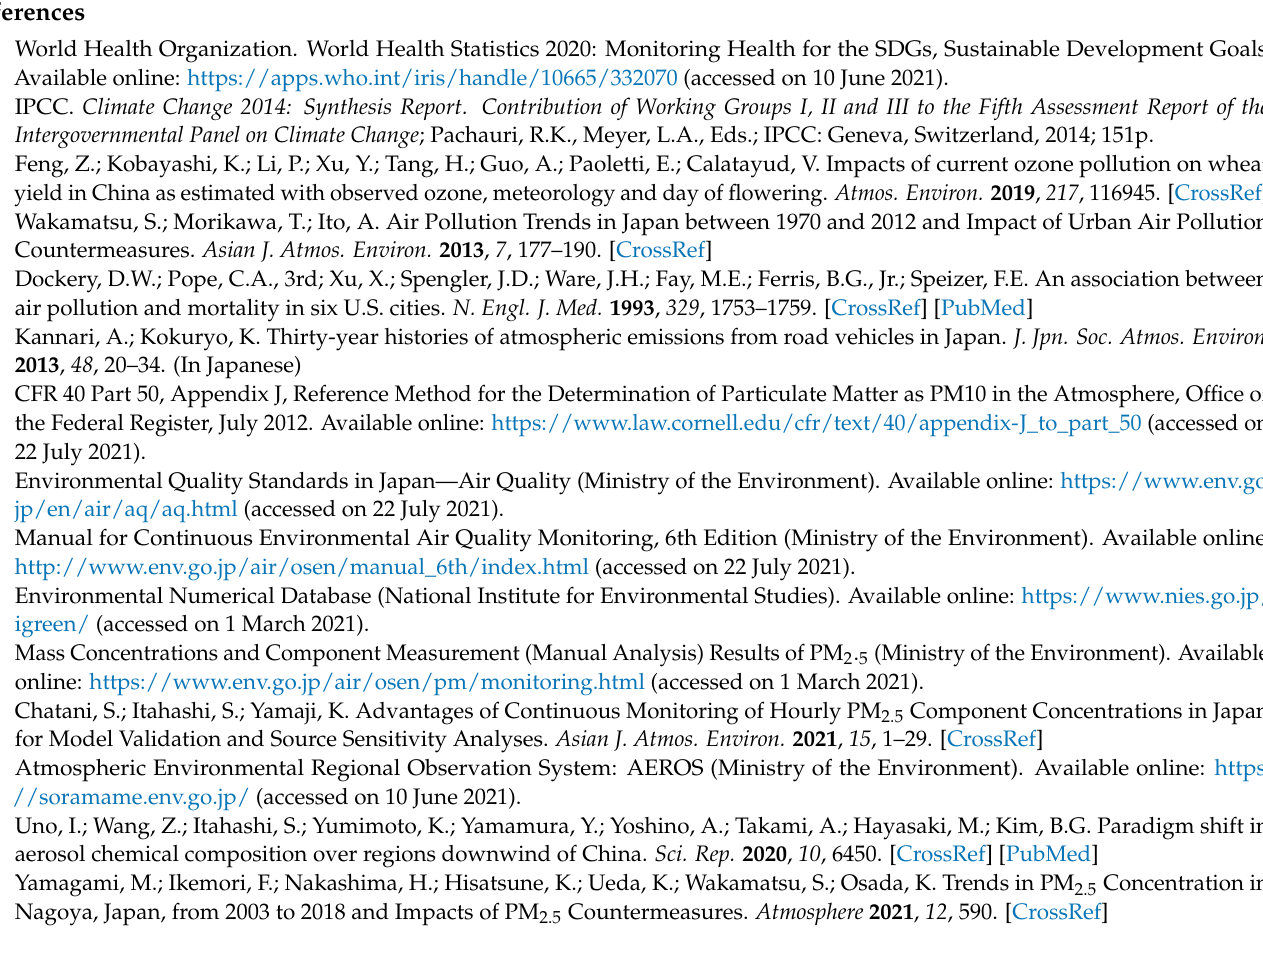
concentrations at the AAQMS for 1990–1992 and 2016–2018, averaged by region, and their ratios, Figure S4-3: Annual average NOx concentrations at the AAQMS and RsAQMS of the nation and each region from 1990 to 2018, Table S4-3: Annual average NOx concentrations at the AAQMS and RsAQMS of the nation and each region in 1990, 2000, 2010 and 2018, and the ratio of concentrations in 2018 to 1990, Figure S4-4: Annual average NMHC concentrations at the AAQMS and RsAQMS of the nation and each region from 1990 to 2018, Table S4-4: Annual average concentration of NMHC at the AAQMS and RsAQMS of the nation and each region in 1990, 2000, 2010 and 2018, and the ratio of concentrations in 2018 to 1990 and 2010 to 2000, Figure S4-5: Annual average SO 2 concentrations at the AAQMS and RsAQMS of the nation and each region from 1990 to 2018, Table S4-5: Annual average concentration of SO 2 at the AAQMS and RsAQMS of the nation and each region in 1990, 2000, 2010 and 2018, and the ratio of concentrations in 2018 to